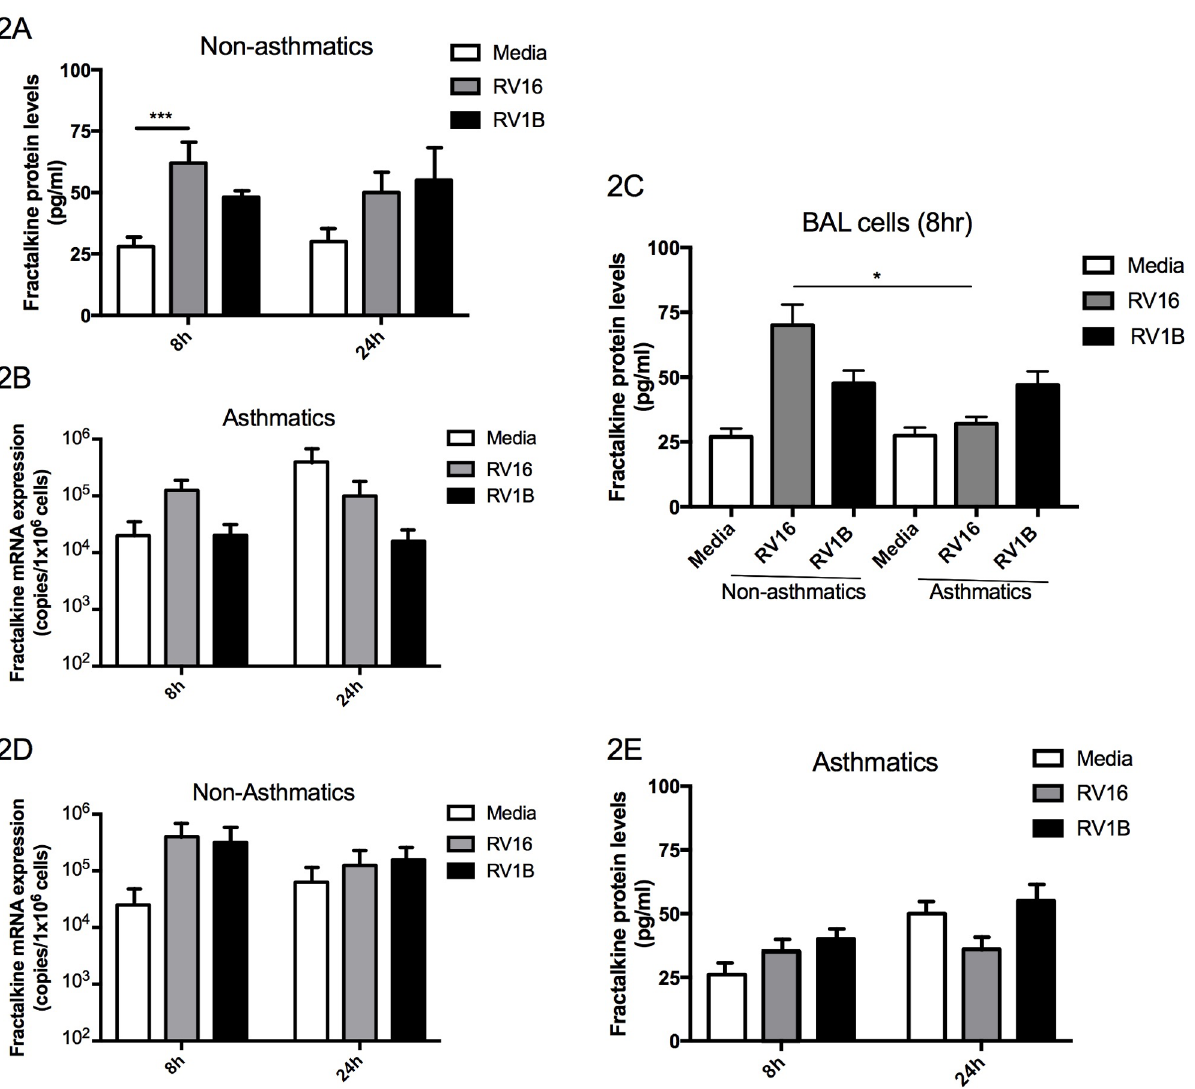
Fig 2. Change in levels of fractalkine in BAL cells following in vitro infection with RV16 and RV1B. Solublefractalkineprotein was measuredin cell supernatantsfrom BAL cells obtainedfrom (A) non-asthmatic (n = 15) and (B) asthmatic (n = 15) subjectsand compared betweensubject groups at 8hrs post infection (C). FractalkinemRNA expressionwas measuredin BAL cell lysate cDNA obtainedfrom non- asthmatic (D) and asthmatic (E) subjects. The results are expressedas mean ± SEM. Protein data were analysedby one-wayANOVA with Bonferroni post-test and mRNA by Kruskal Wallis with Dunn’spost test ( ** P < 0.01).